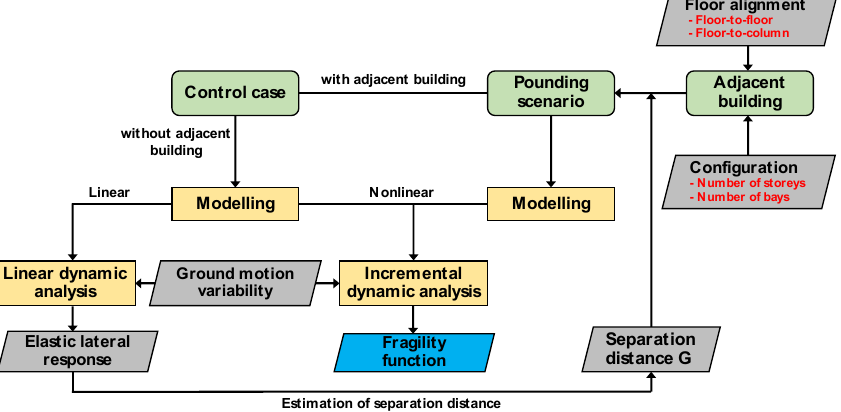
Figure 1. Flowchart describing the adopted methodology.